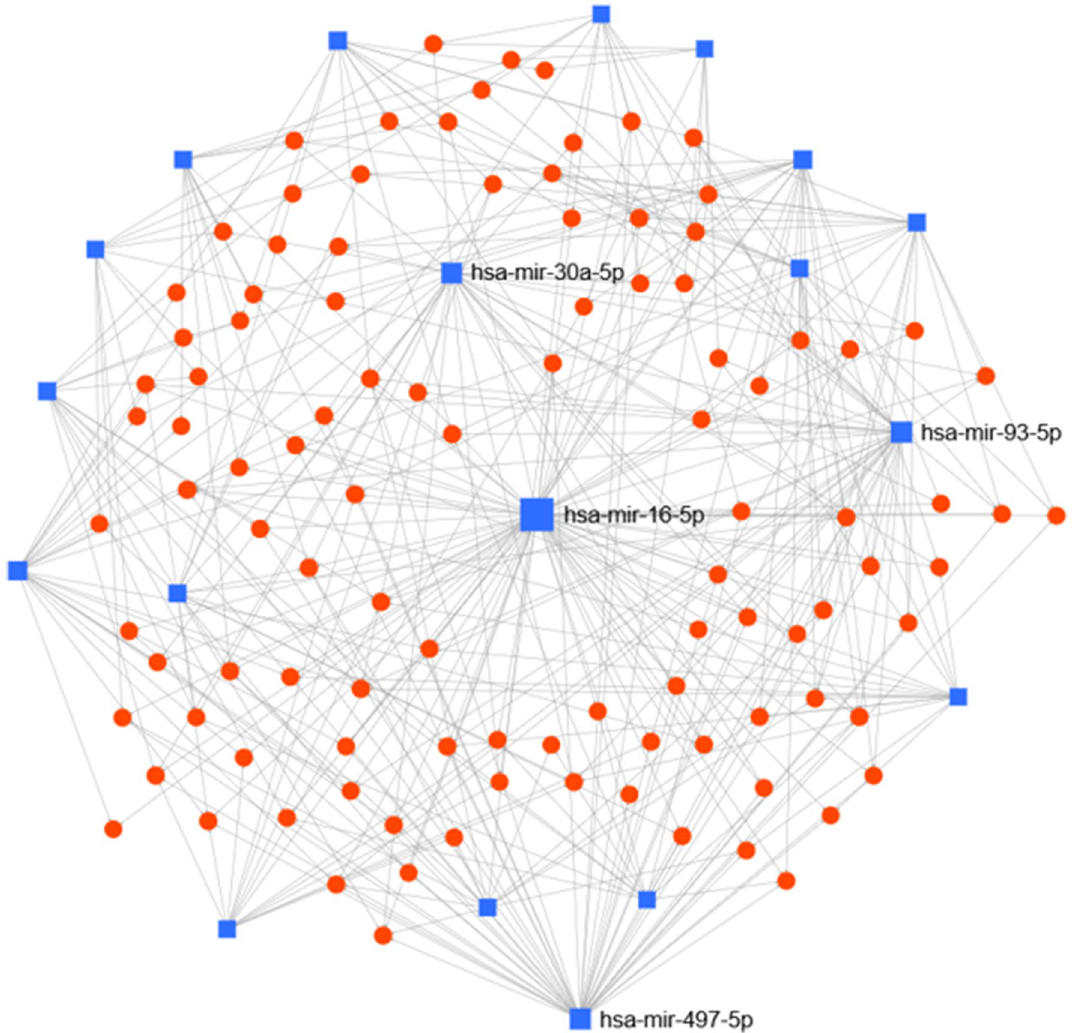
Figure 6. Network analysis of differentially expressed miRNAs and their target genes in HIV-1 infected human milk. Network display showing differentially expressed miRNAs (Fold change 1.3; P < 0.05) and their target genes in HIV-1 infected human milk. Cluster hubs shown in blue squares indicate miRNAs whereas red circles depict their target